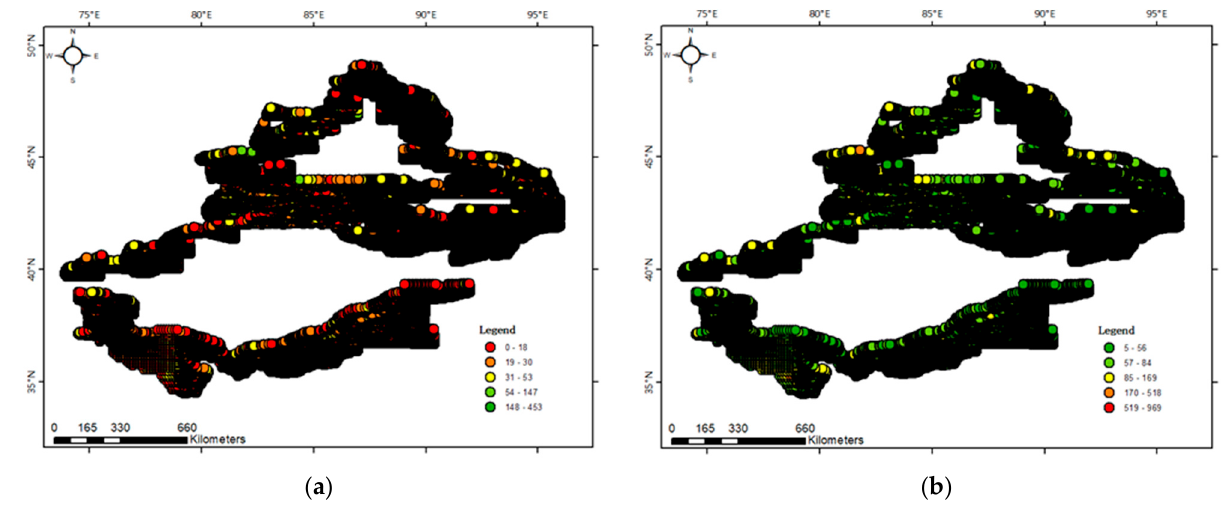
Figure 5. Xinjiang geochemical element display: ( a ) Cu; ( b )